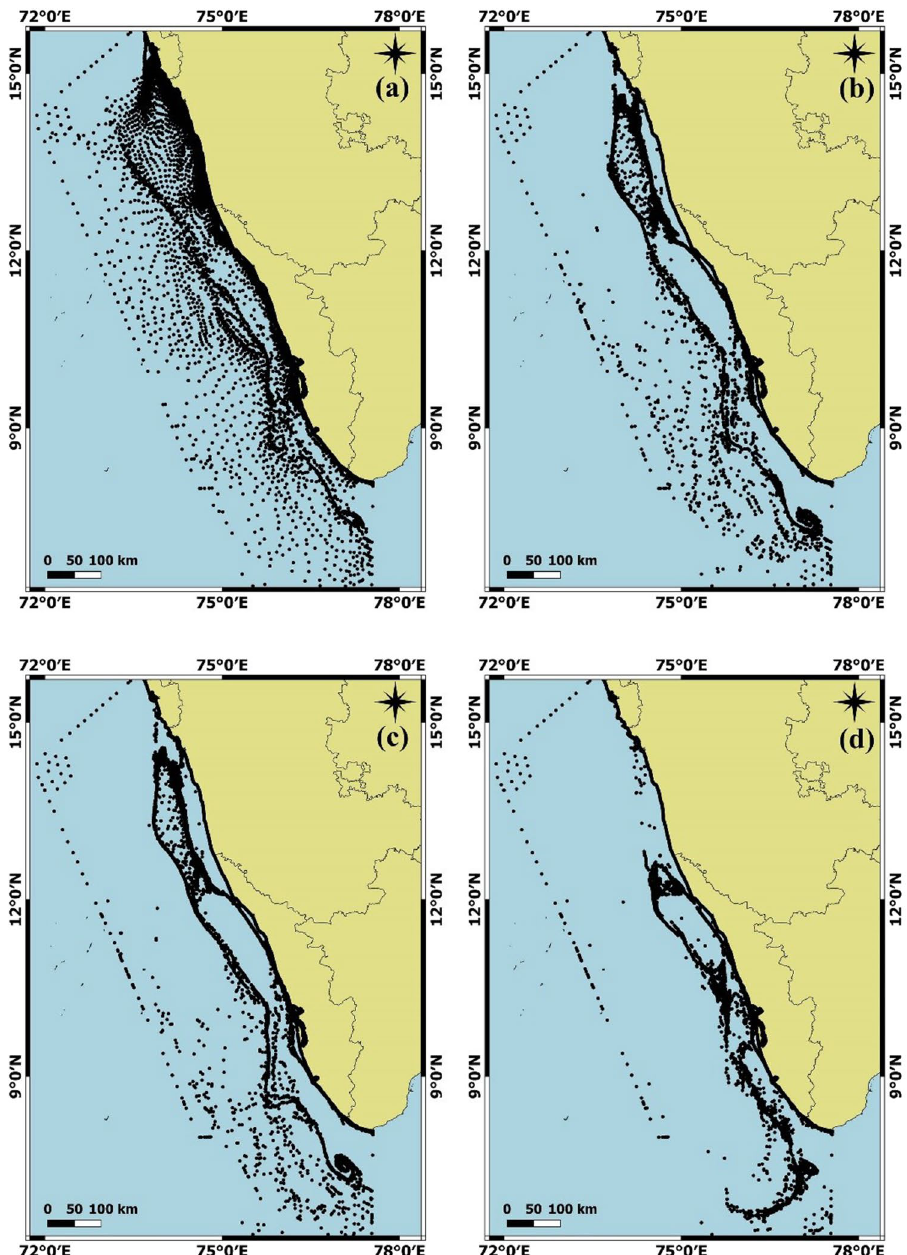
Figure 5. Larval dispersal along the southwest coast of India modelled using FVCOM (Finite volume community ocean model). Transportation of particles from initial release during July 2014 after ( a ) 1 day ( b ) 5 days ( c ) 10 days ( d ) 20 days. The plot was generated with GMSH software (https:// gmsh.